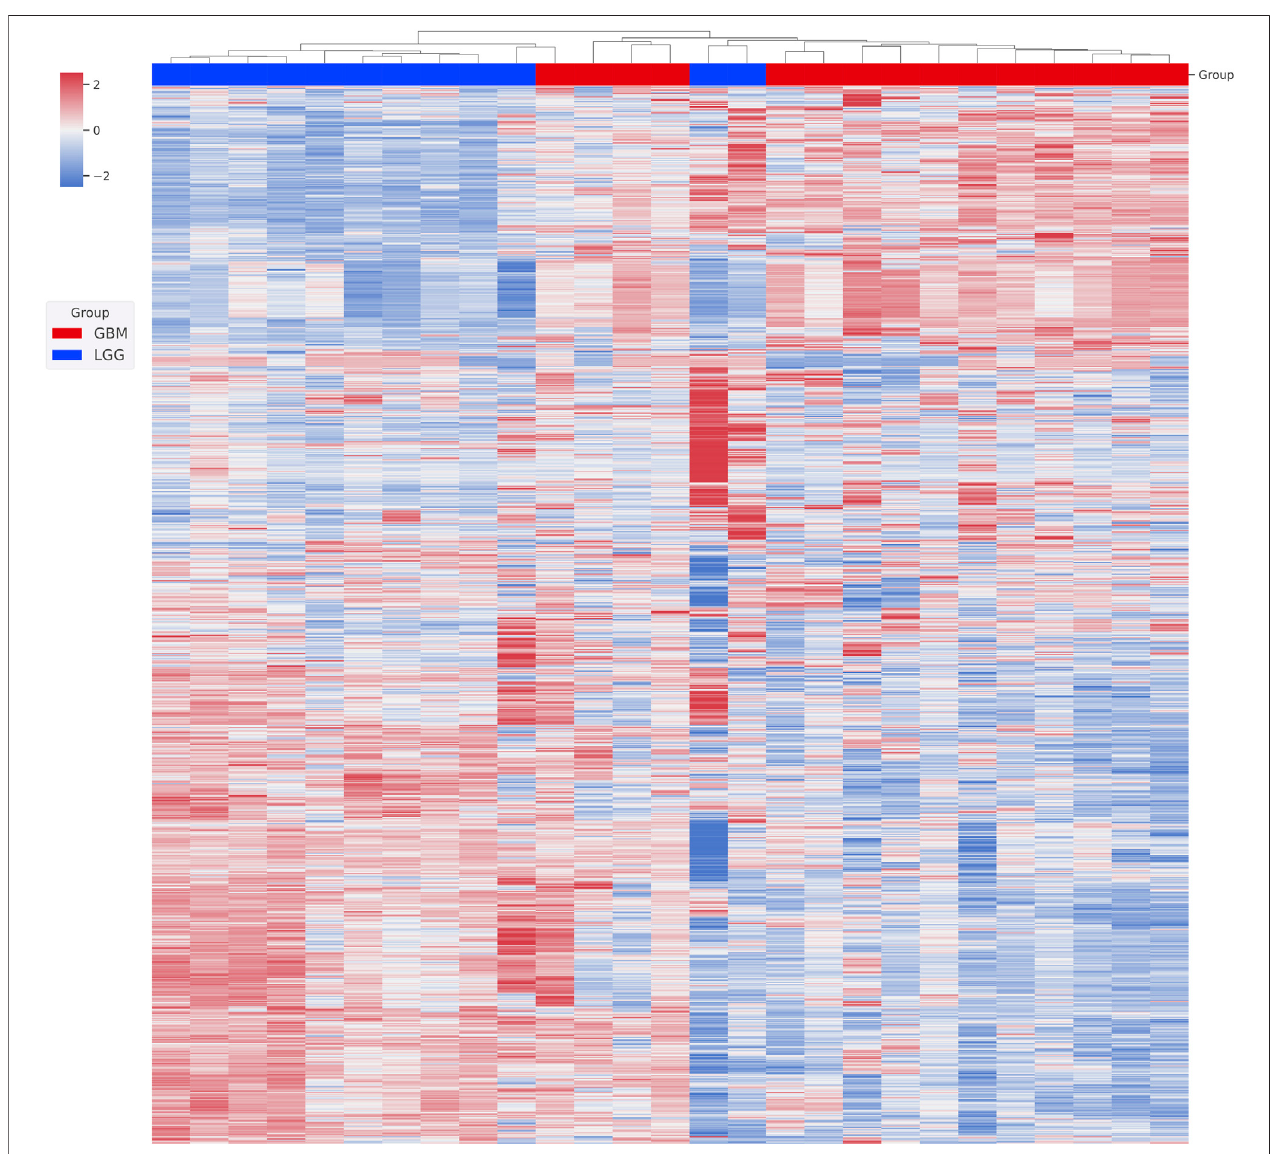
FIGURE 1 | Unsupervised clustering of patient gene expression pro fi les. The transcriptome of each patient was fi rst obtained from RNA-seq analysis. The top 2,000 genes with differential expression were then used in hierarchical clustering. Relative gene expression levels (from +2 to -2) are indicated by red and blue color shades. Patients ’ WHO classi fi cations at diagnosis are color